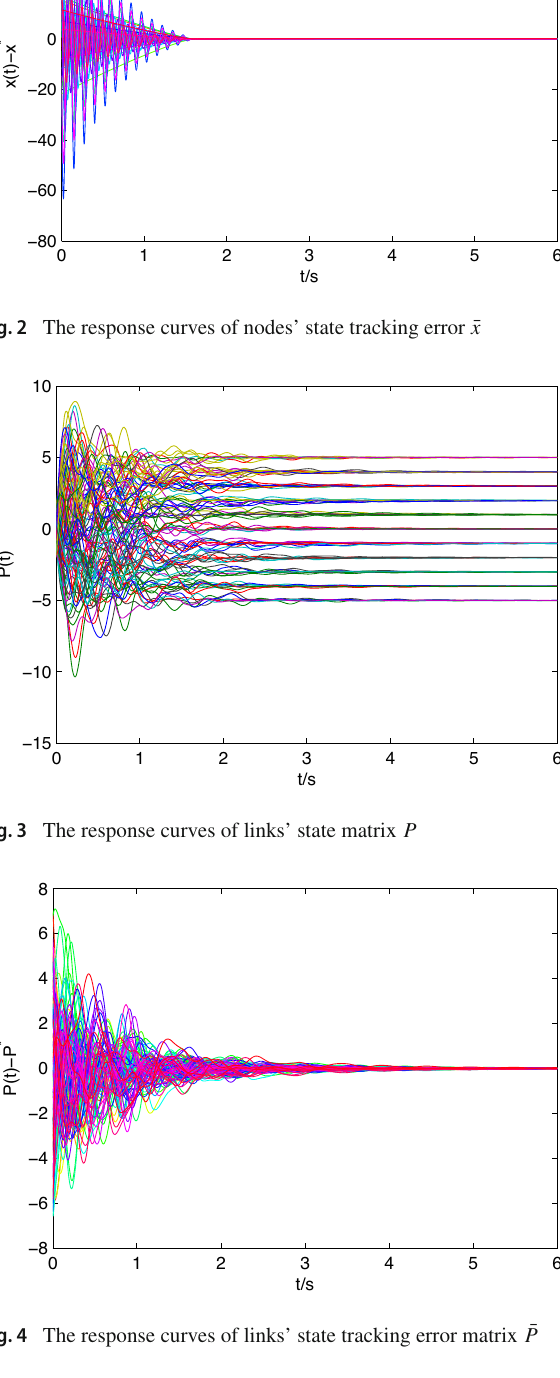
Fig. 4 The response curves of links’ state tracking error matrix ¯